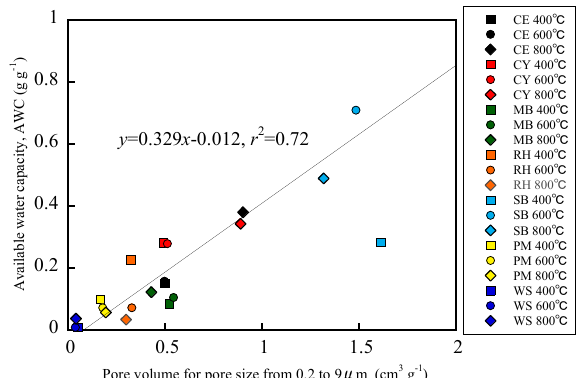
Figure 5. Relationship between volumes for pore sizes from 0.2 to 9 µm, estimated from pore size distribution (PSD) measured by the mercury intrusion porosimetry (MIP) method, and available water capacity, estimated from water retention curves (WRCs), of biochar samples.